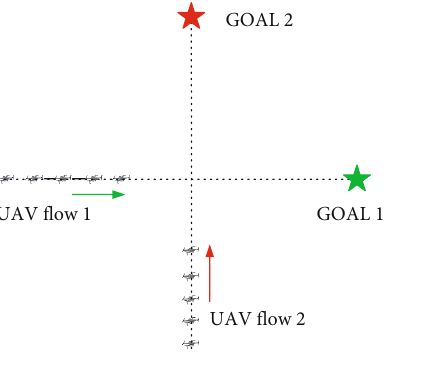
Figure 6: Con fl ict scene of UAV fl ow.